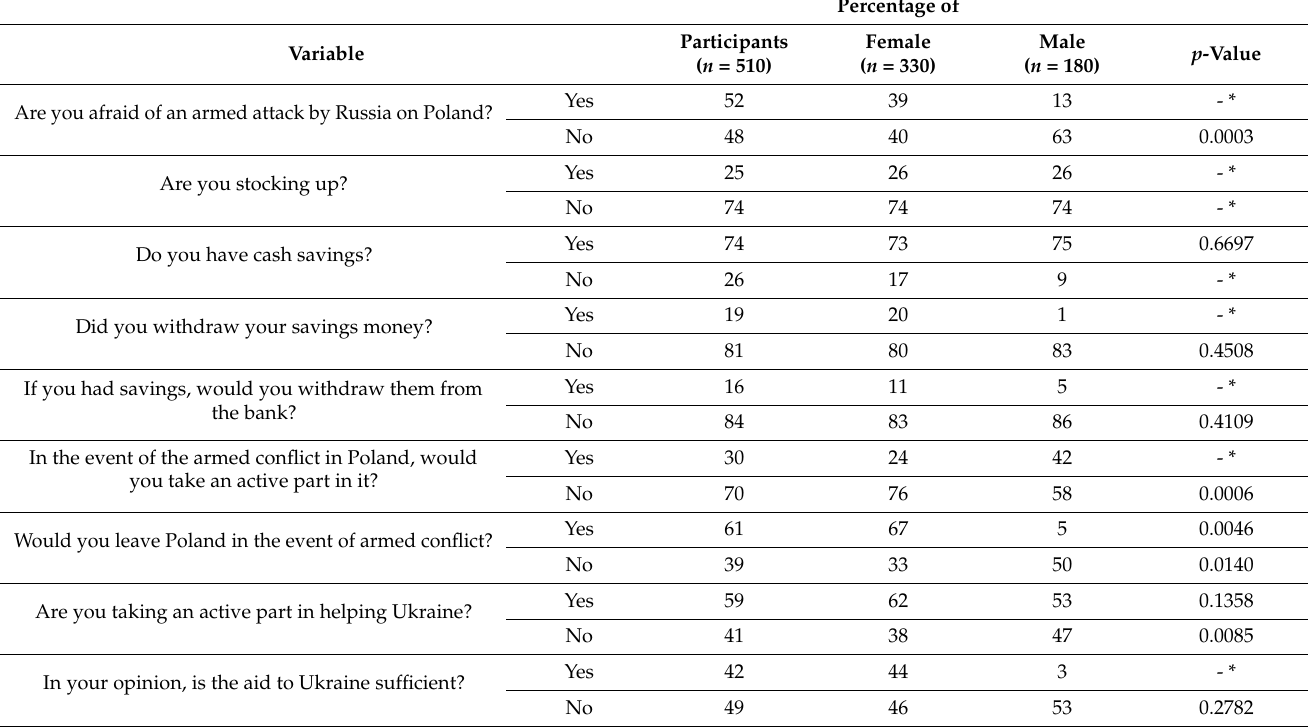
Table 1. Comparison of the percentage of men and women in terms of answers to the questions.